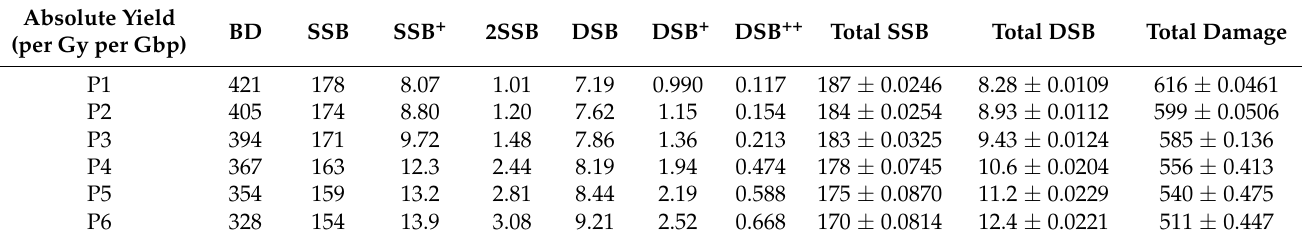
Table 2. Absolute yield of DNA damage (per Gy per Gbp) induced by a 62 MeV proton beam at normal oxygen concentra- tions (21%).